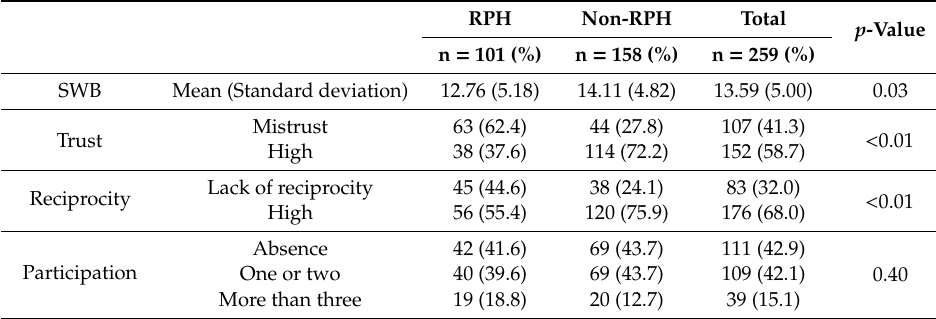
Table 2. SWB and social capital of the two respondent groups.